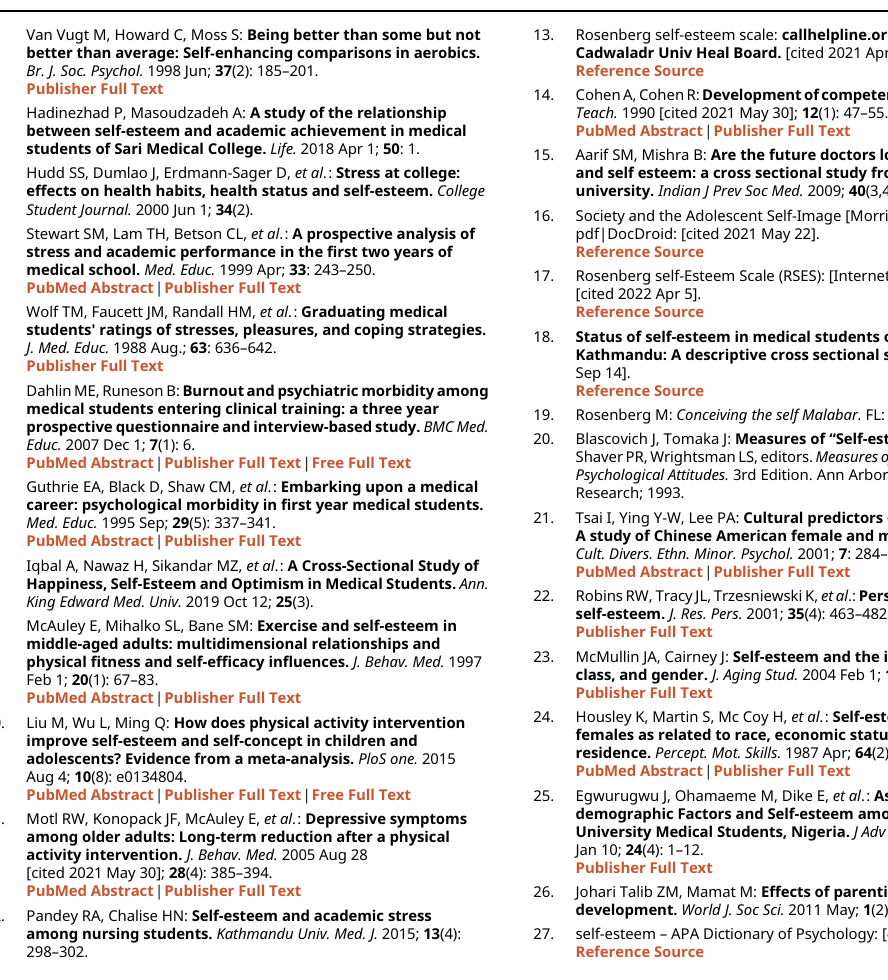
Figshare: ‘ Status of self-esteem in medical students of a college in Kathmandu: A descriptive cross sectional study ’ . https://doi.org/10.6084/m9.figshare.15149589. 18 This project contains the following extended